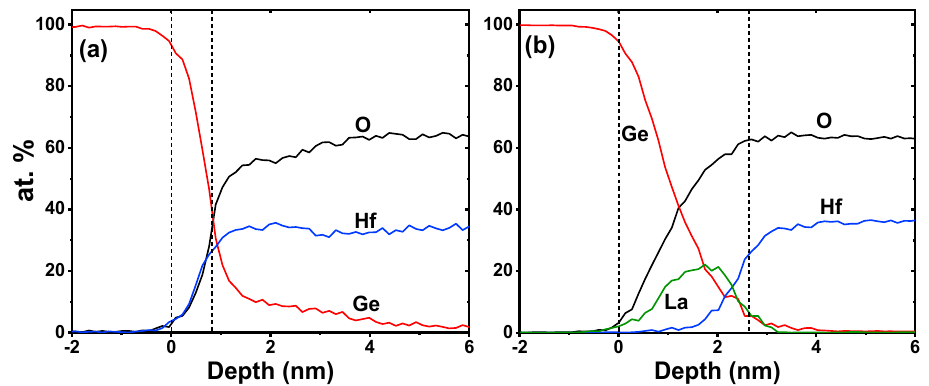
Figure 4. EDX profiles near the interfaces between the deposited films and Ge substrates. ( a ) the control sample; ( b ) sample S4 with 15 ALD cycles of La 2 O 3 passivation layer.